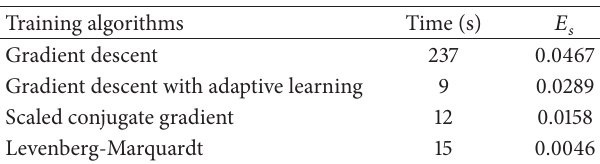
Table 4: Network validation performance with different training algorithms.